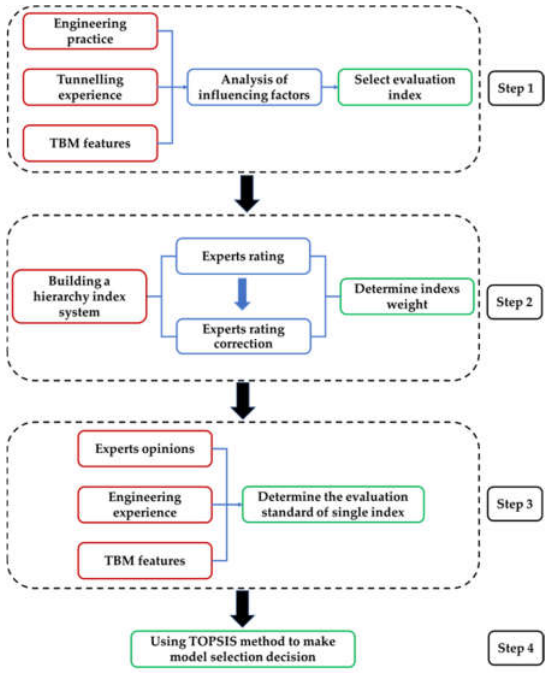
Figure 1. Flow chart of TBM selection decision-making model.